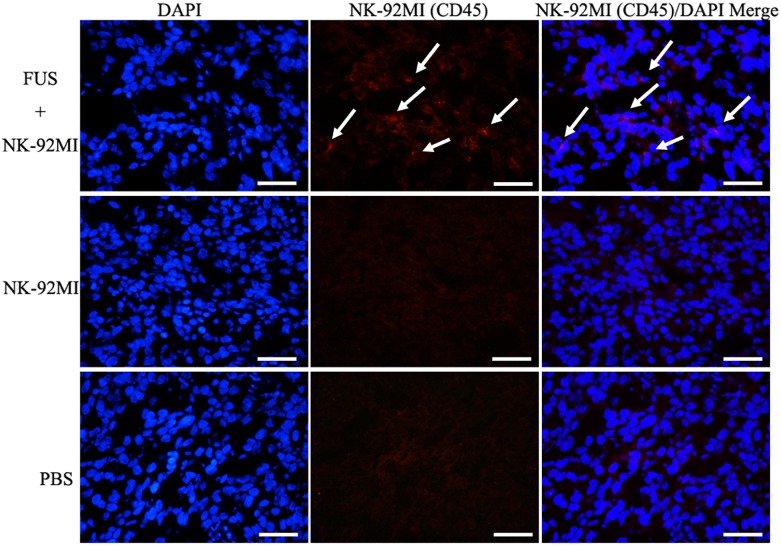
Immunofluorescence evaluation of NK-92MI cells in tumor. Anti-CD45-Cy3 (Red) staining of tumor regions show accumulation of NK-92MI cells (white arrows) in the FUS+NK-92MI group. Nuclei were stained with DAPI (Blue). Scale bar: 50 μm.